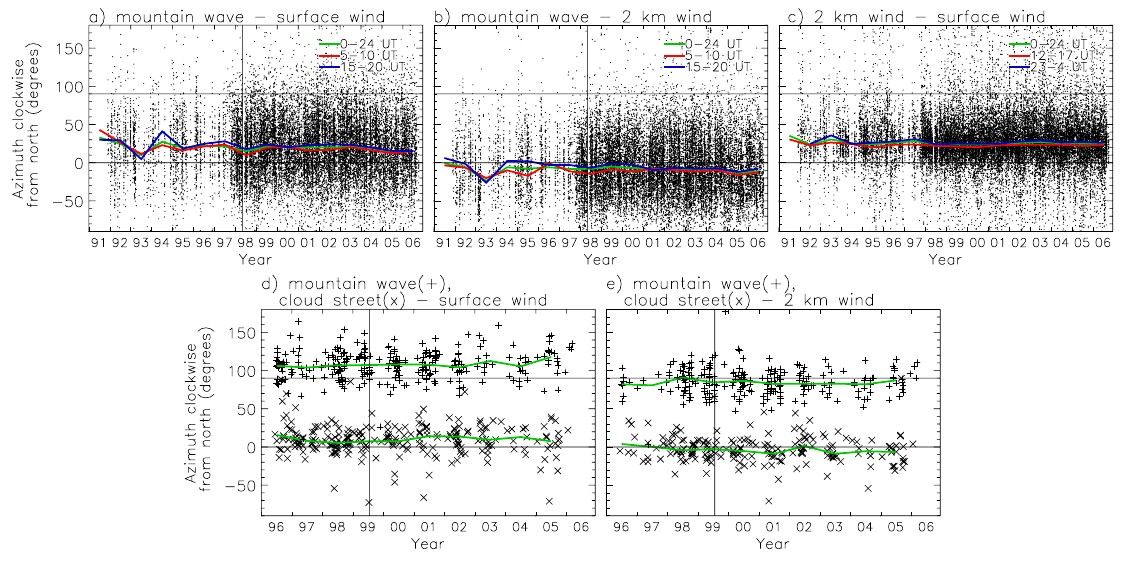
Fig. 10. Differences of wind and wave azimuths, using (a–c) VHF radar, 1991–2006, (d, e) satellites, 1996–2006, and surface wind averaged from up to 26 sites (Fig. 1). Green, red and blue lines show yearly medians, for 00:00–24:00 UT and other time intervals. Vertical lines in (a, b, d, e) show last data in Worthington (1999b, 2001). Dots in (c) are for every third data point. Mountain-wave azimuth is of horizontal wavevector for (a, b), and wave clouds for (d, e), measured clockwise from